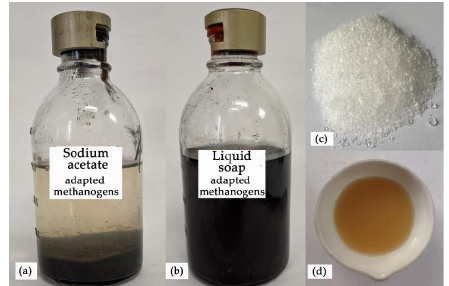
prepare model stocks. well as sodium acetate crystals ( c ) and liquid soap ( d ), which were added to fermentation jars to